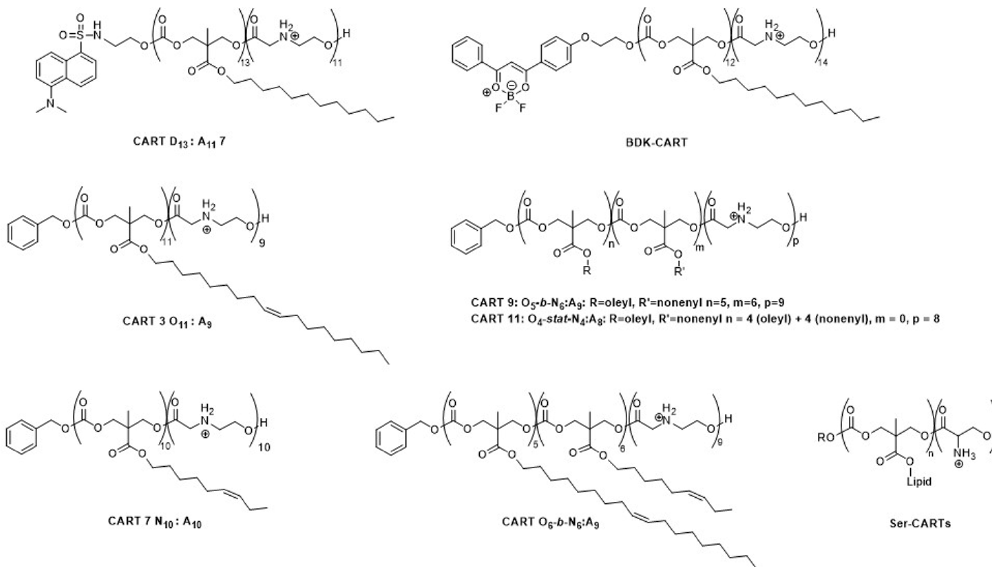
Figure 7. Representative chemical structure of